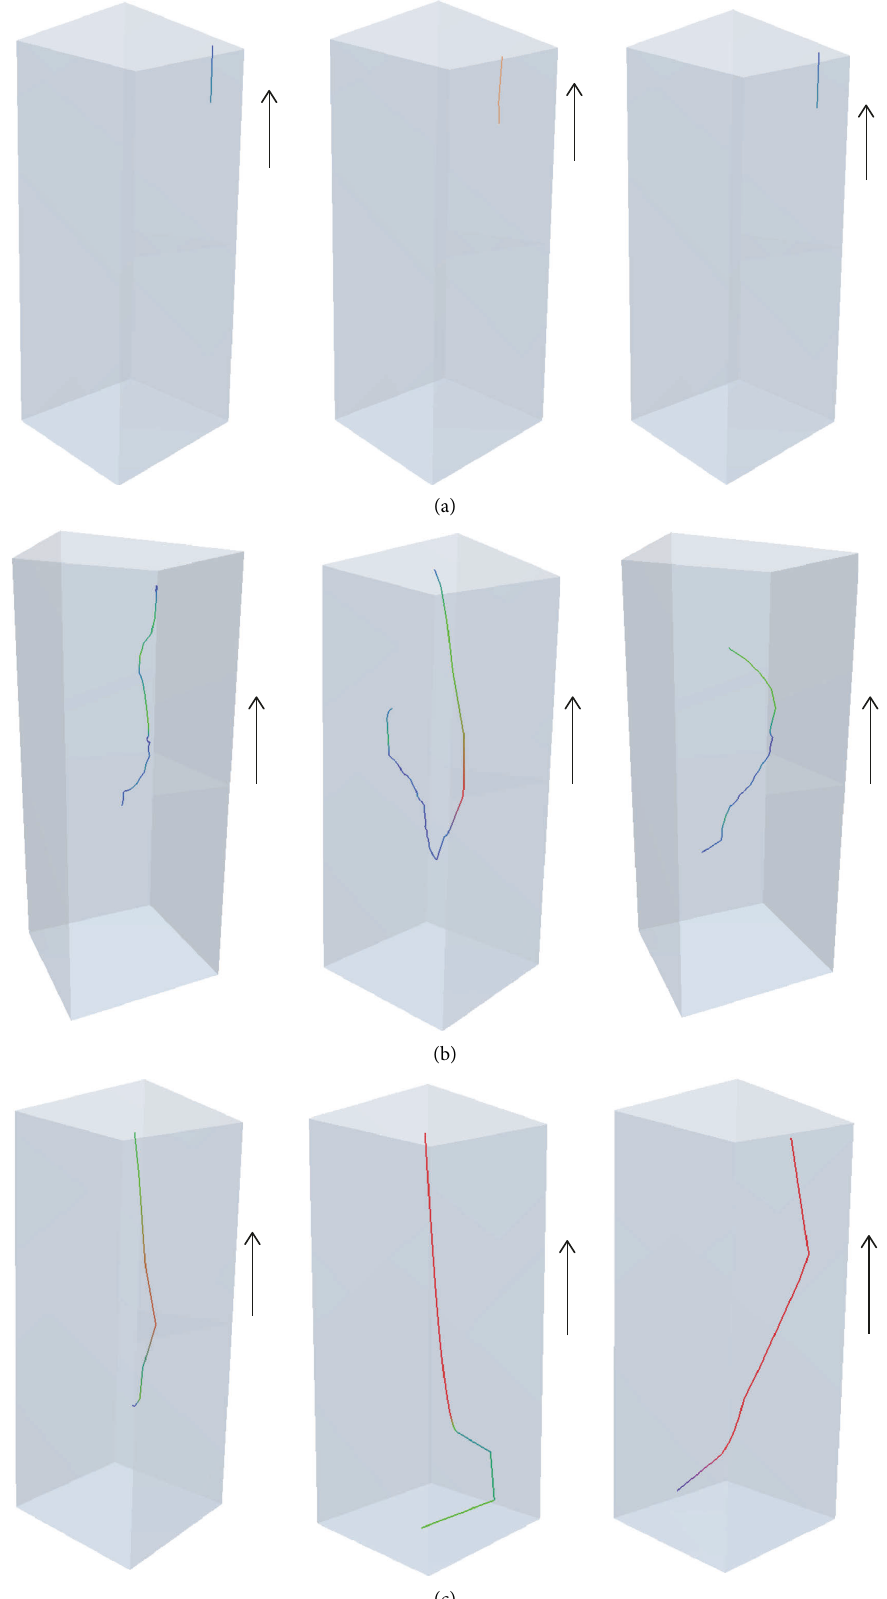
Figure 4: Particle trajectory. (a) Outlet area particles, (b) middle section particles, and (c) inlet area